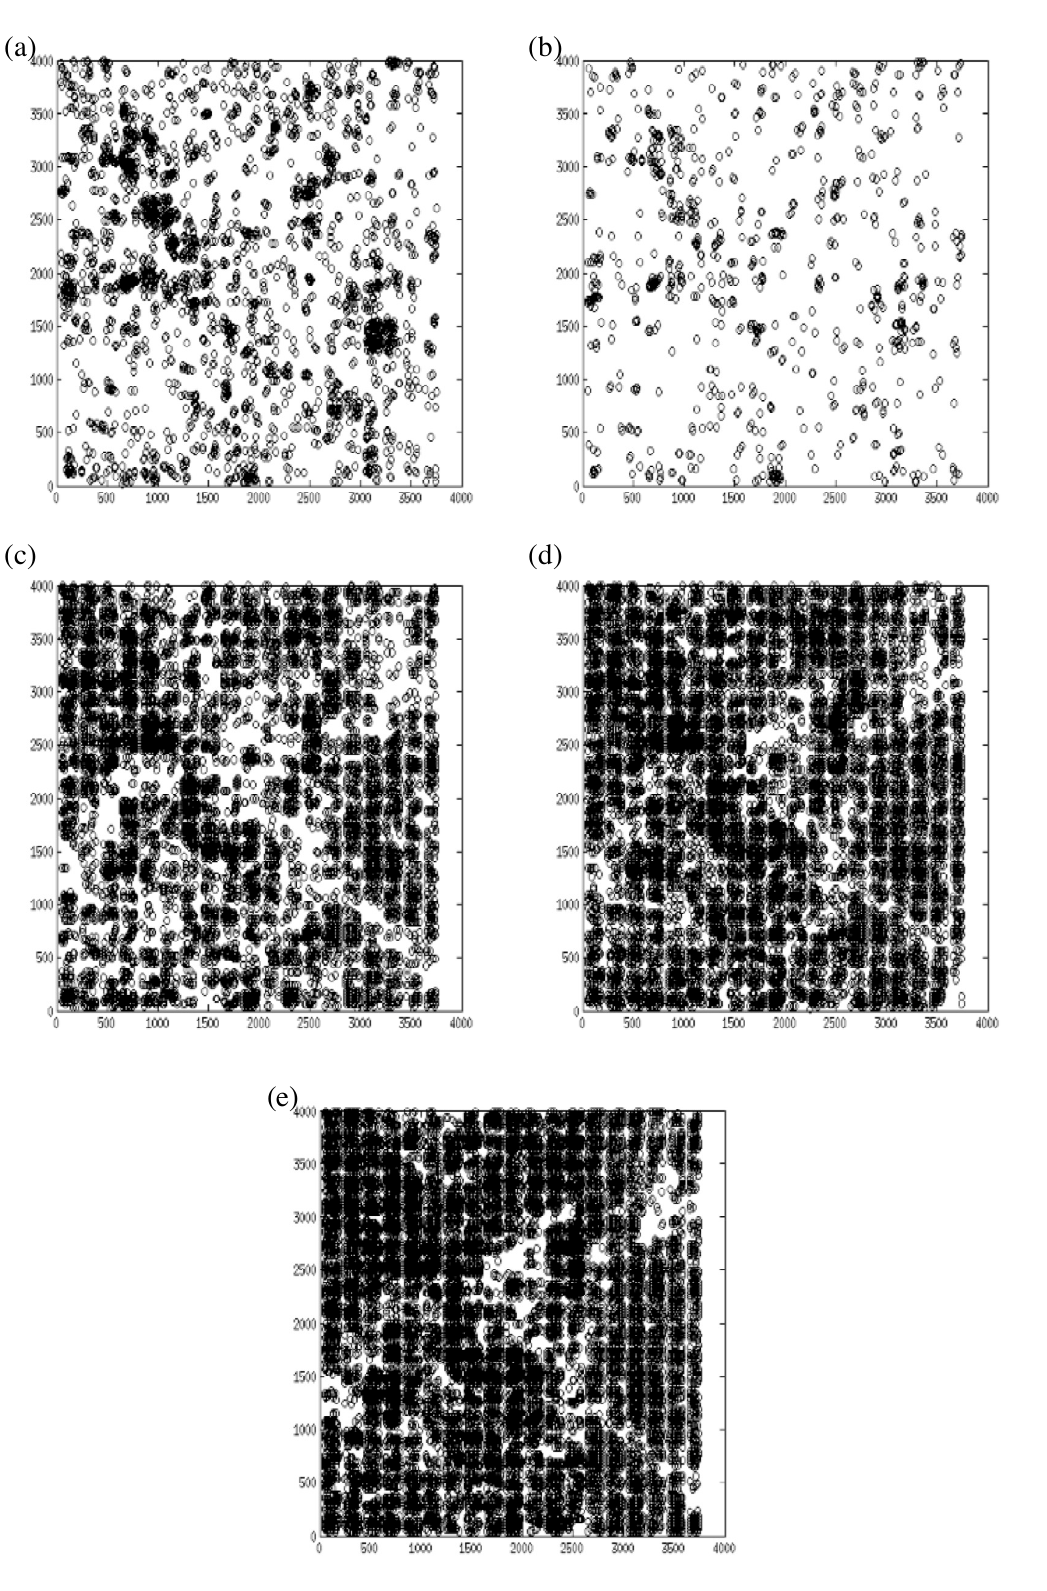
Figure 8. Control points distribution images of Sample 3 using: ( a ) SIFT; ( b ) SURF; ( c ) SSD; ( d ) NCC; and ( e )